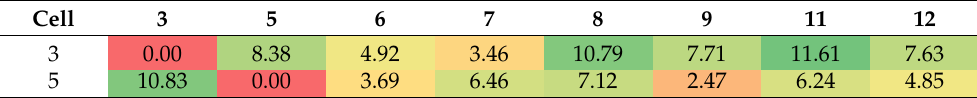
Table 4. Values for the relative deployment index ( DI ), as defined in Equation (5), for the cells under study. Cell 3 Table 5. Separability index ( SI ) as defined in Equation (6). Better results shown in green.